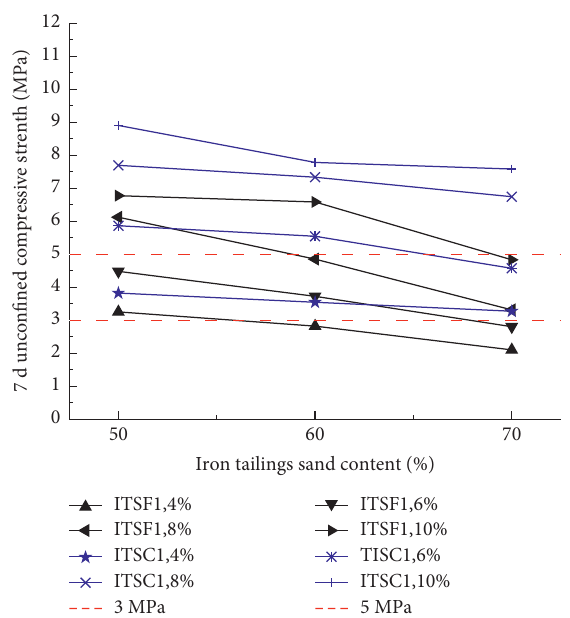
Figure 8: 7d unconfined compressive test results in different mixing ratio.